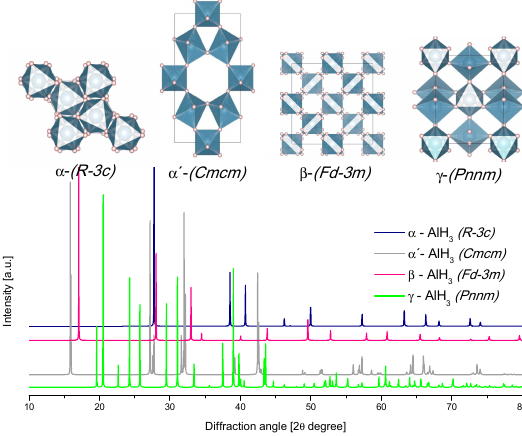
Figure 4. Crystal structure of several alanes and their calculated diffraction patterns ( λ = Cu k α 1 ).